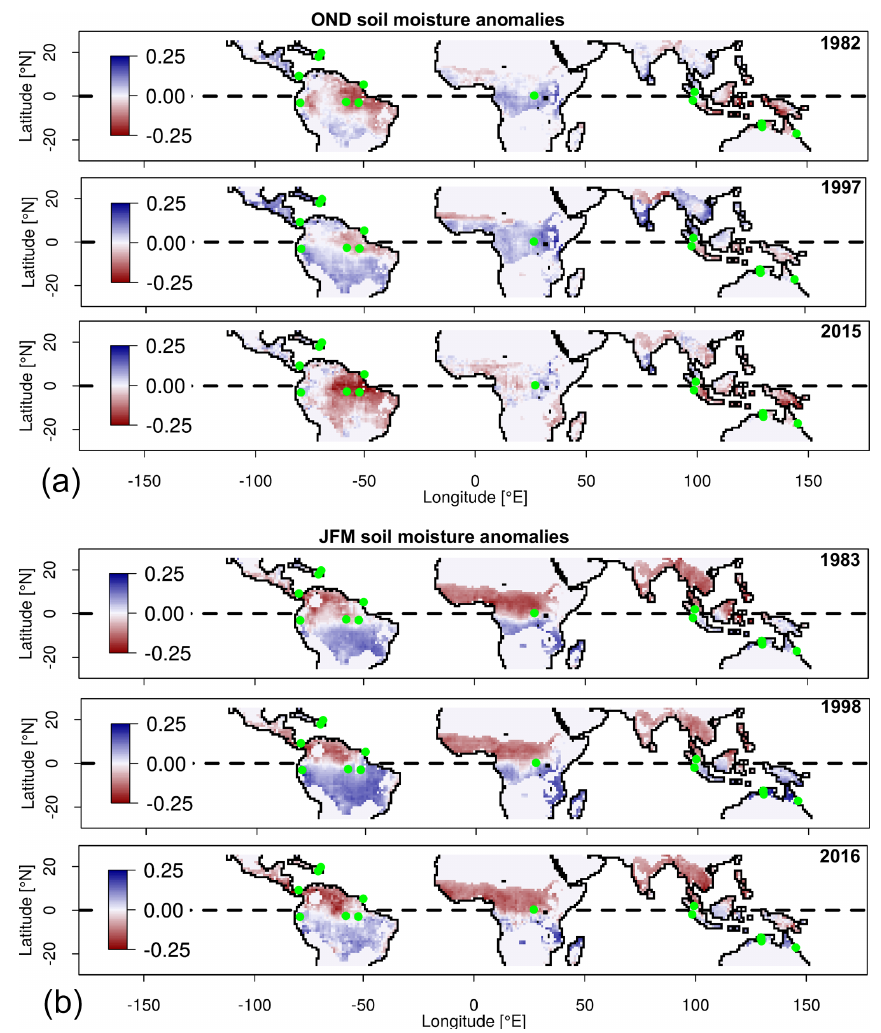
Figure 5. (a) October-to-December (OND) change in bias-corrected GLDAS soil moisture anomalies during the super El Niño years 1982, 1997 and 2015 relative to the previous years. Anomalies relative to the 1979–2016 period. (b) Same as (a) but for January to March (JFM) in 1983, 1998 and 2016. Table 3. Mean and standard deviation of October-to-December (OND) and January-to-March (JFM) change in the soil moisture for clustered regions in the humid tropics. Statistics computed using OND and JFM bias-corrected GLDAS soil moisture anomalies during El Niño